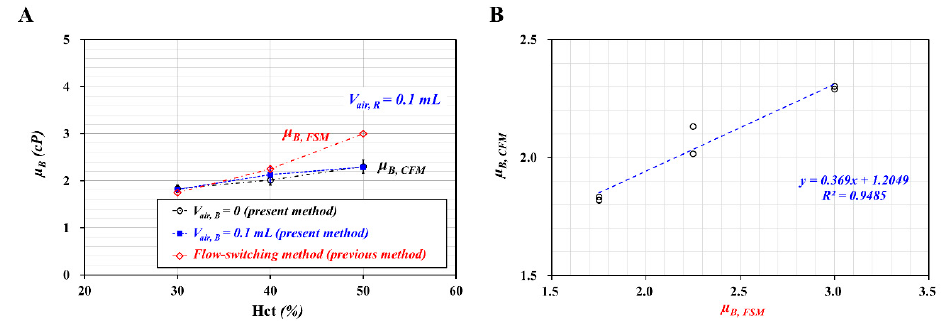
Figure 4. Quantitative comparison of blood viscosity ( μ B ) between the co-flowing method (present method) and a flow switching method (previous method). To evaluate the effect of V air, B on μ B , V air, B was varied from 0 to 0.1 mL. Here, V air, R was set to 0.1 mL. ( A ) Variations of μ B obtained with two different methods with respect to Hct. ( B ) The inset shows the linear relationship between μ B, CFM (co-flowing method) and μ B, FSM (flow switching method).